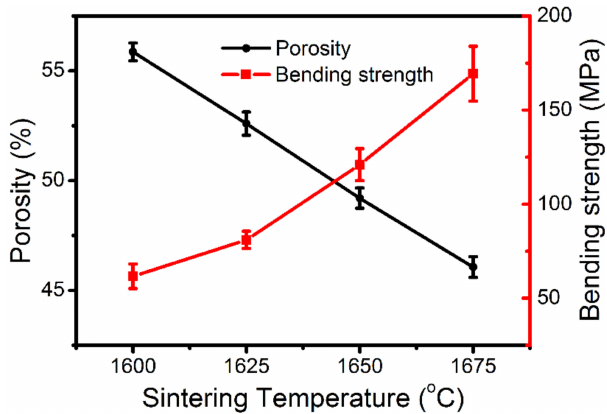
Figure 6. Influence of sintering temperature on porosity and the three-point bending strength of the membranes (the results presented are the average values (and their SD) from five independent measurements).